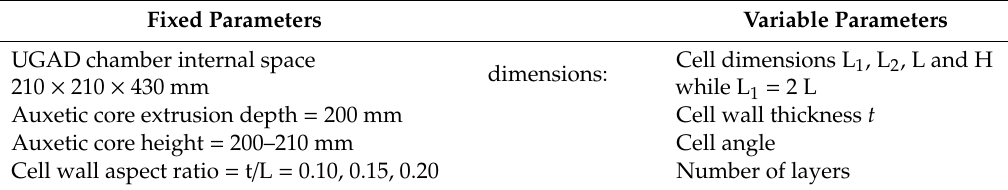
Table 1. Fixed and variable geometrical parameters of the UGAD auxetic core.